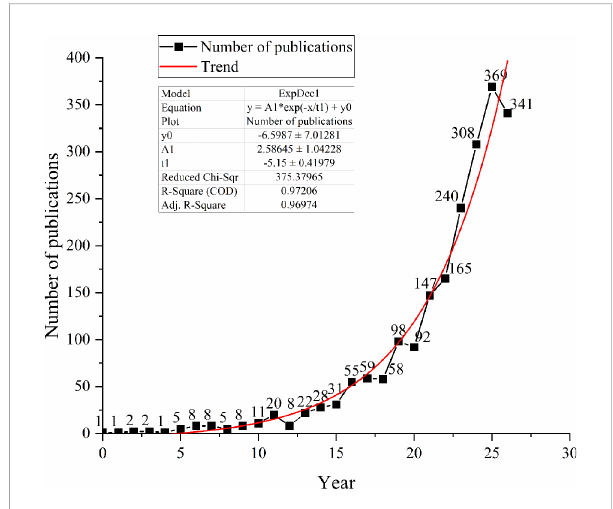
FIGURE 1 Annual publication and citation number from 1996 to 2022 at